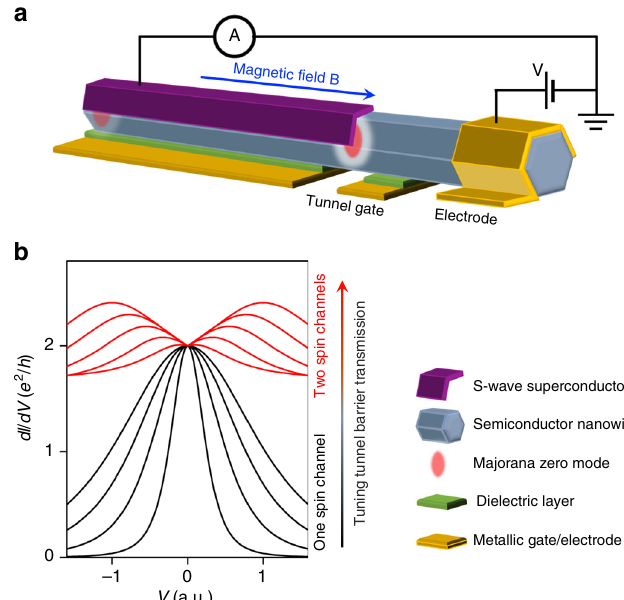
Fig. 1 Majorana device for tunnel-gate control. a Schematic experimental setup of the simplest Majorana nanowire device for tunneling spectroscopy measurement. b Schematic plot of differential conductance dl / dV as a function of bias voltage V for different tunnel barrier transmission controlled by the tunnel-gate. Increasing the tunnel barrier transmission, the d I /d V shows a peak (black) to dip (red) transition with the zero bias conductance always quantized at 2 e 2 / h , at suf fi ciently low temperature. The zero bias peaks (black) correspond to the case with only one spin- resolved channel in the tunnel barrier. The Majorana conductance still remains quantized for the two spin-resolved channels (red) due to the spin selection process of MZM. All the plots and devices in this paper are only for schematic purpose and not to